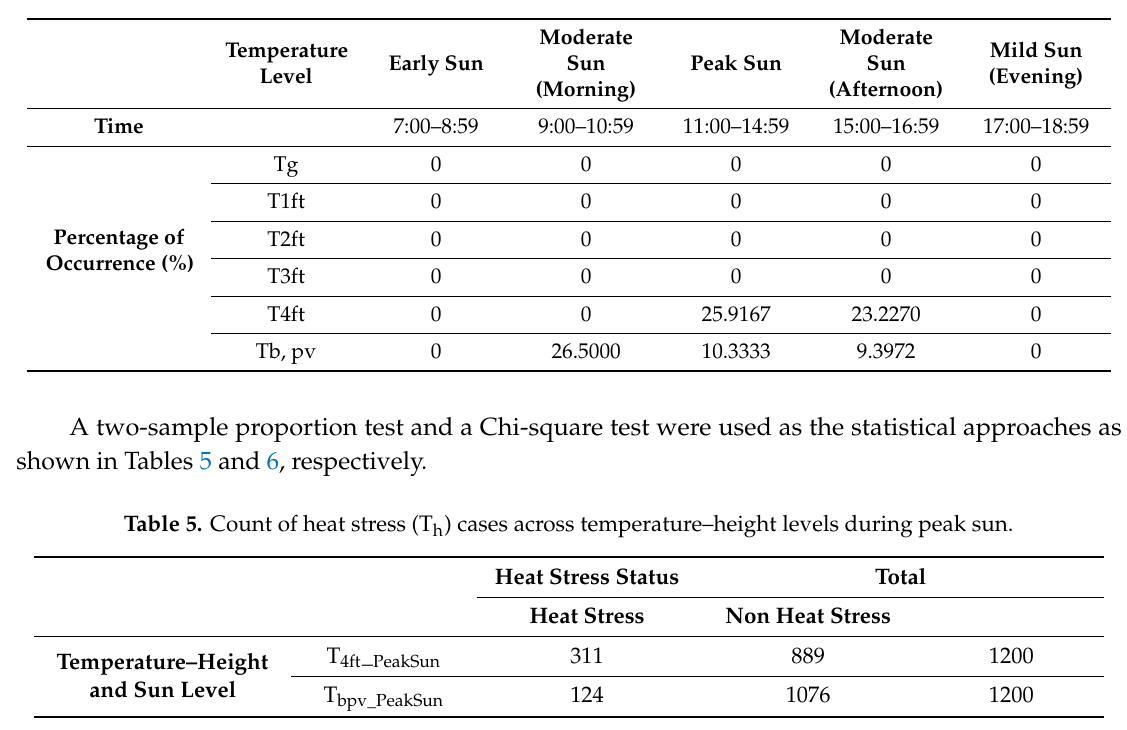
Table 4. Percentages of heat stress (T h ) occurrence across sun level and height.